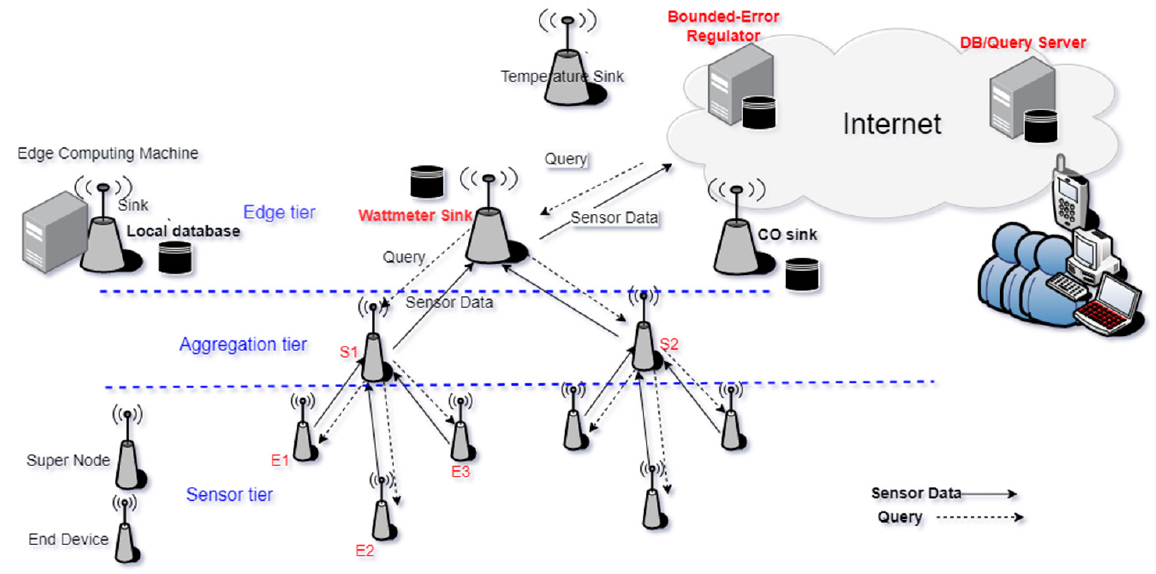
Figure 2. System architecture of an edge-computing OBEQ for IoT (S1, S2 are SNs, E1–E3 are EDs).